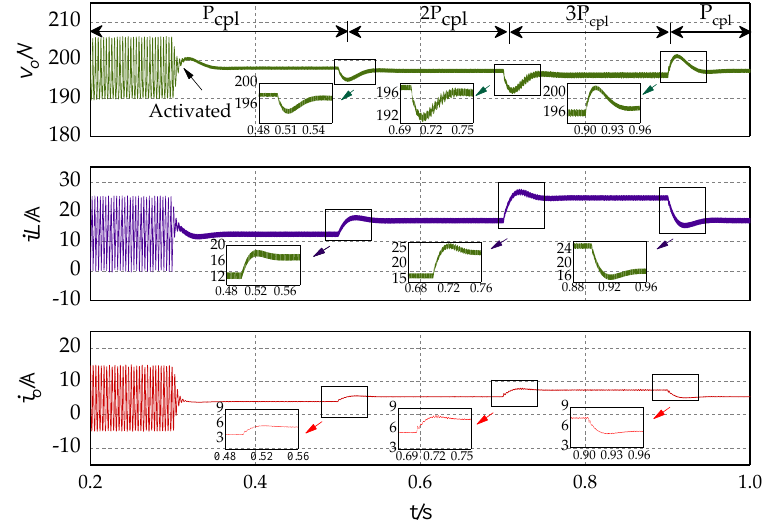
Figure 11. Simulation results of a DC microgrid system with the change of operation points.